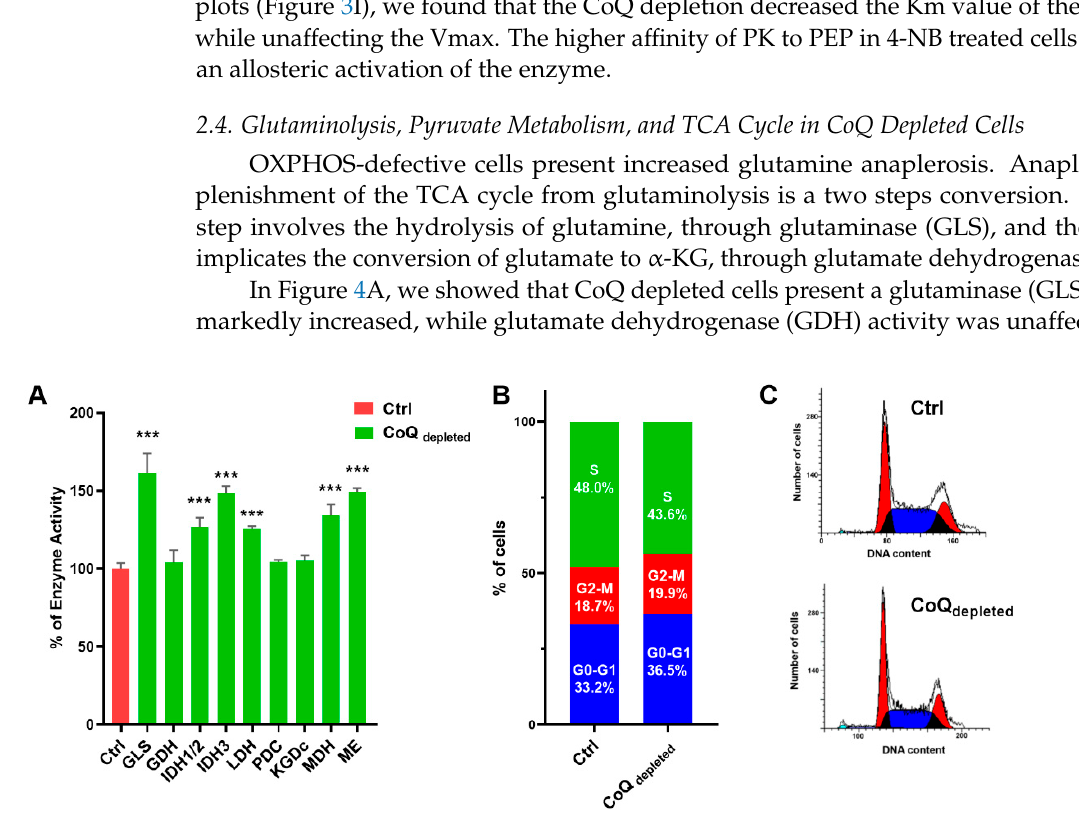
Figure 4. CoQ depletion induces alteration in enzyme activities and cell cycle. MCF-7 cells were cultured in complete DMEM for 96 h in the presence of 4 mM 4-nitrobenzoic acid (CoQ depleted) or vehicle (CTRL). ( A ) Enzyme activities (glutaminase, GLS; glutamate dehydrogenase, GDH; isocitrate dehydrogenase1,2 and 3; IDH1/2, IDH3; lactate dehydrogenase LDH; pyruvate dehydrogenase complex, PDC; α -ketoglutarate dehydrogenase, KGDC; malate dehydrogenase, MDH; malic enzyme ME) in control and CoQ depleted cells. Data refers to the percentage increase in comparison with controls. ( C ) Cell cycle analysis and quantification ( B ) by flow cytometry in control and CoQ depleted cells using propidium iodide dye staining. The column graph shows the percentage of cells in each cell cycle. Statistical analysis was performed using GraphPad Prism software. Error bars indicate the standard error of the mean (SEM). p values were obtained using the analysis of variance (ANOVA) followed by Tukey’s post hoc test. *** p ≤ 0.001.